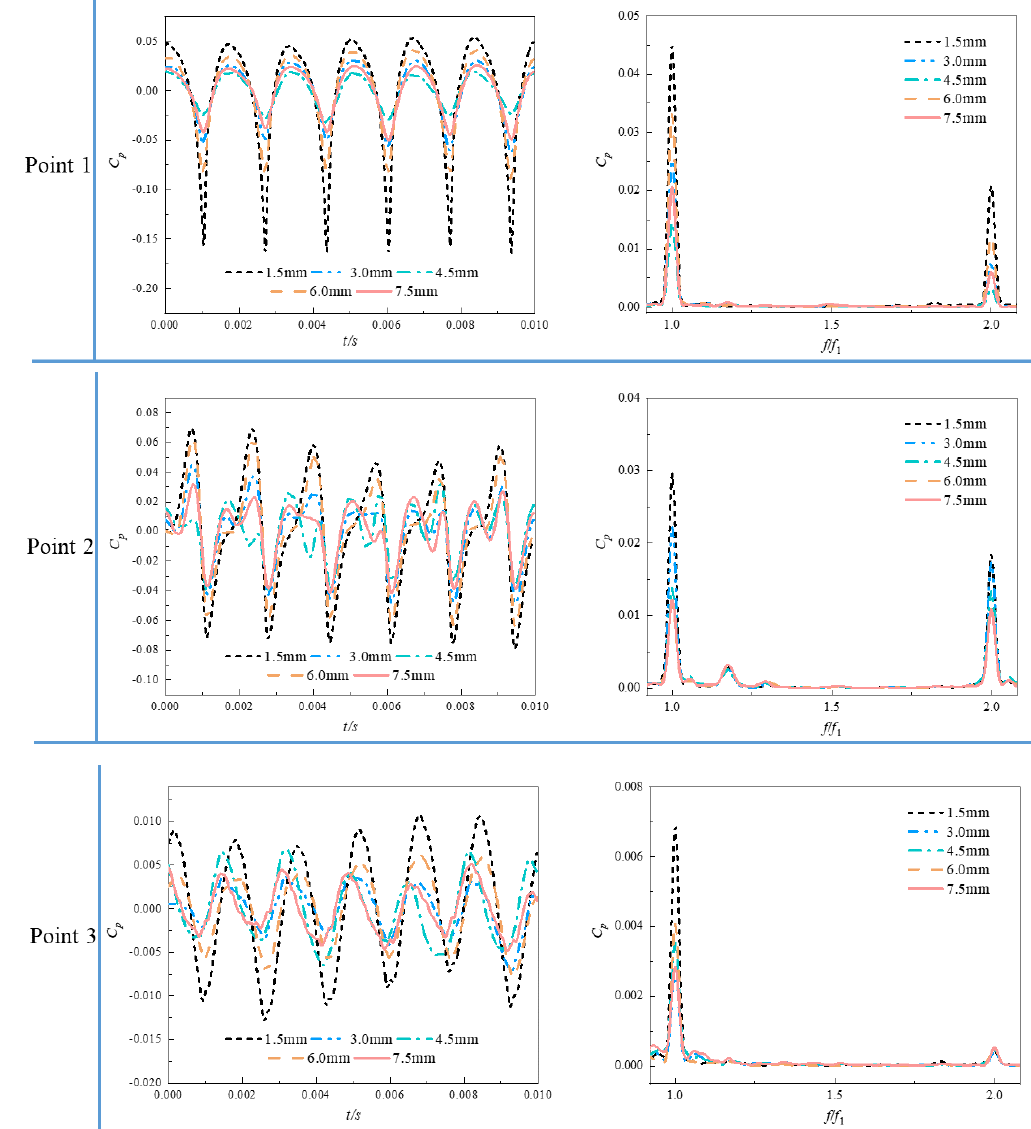
Figure 12. Pressure pulsation characteristics within the chamber under rated flow condition.